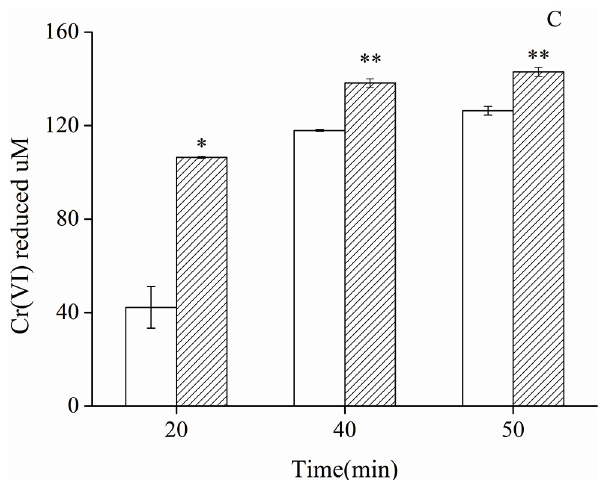
Figure 2. ( A ) Comparison of Cr(VI)-reducing ability of cultured HepG2 ( □ ) and HepG2-YieF ( ▧ ) cells at different time points. ( ■ ) indicates cell-free control. * p < 0.05, ** p < 0.01; ( B ) Absolute concentration of remaining Cr(VI) in HepG2 ( ■ ) and HepG2-YieF ( ● ) cell crude extract at different timepoints; ( C ) The lessened amount of Cr(VI) in HepG2 ( ▢ ) and HepG2-YieF ( ▨ ) cell crude extract by calculation. Mean and SEs were obtained from three separate measurements of a representative experiment. Experiments were replicated at least twice. Error bars were in some cases smaller than the size of the symbol. * p < 0.05, ** p <